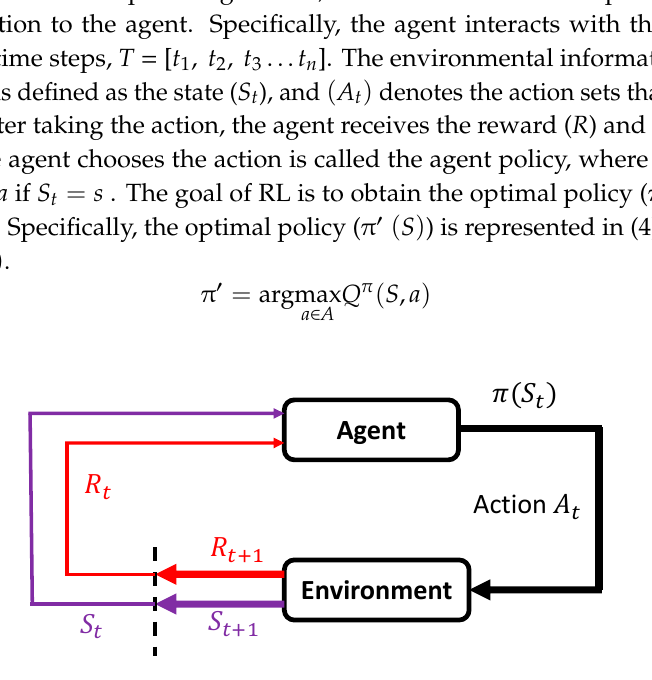
Figure 6. Structure of reinforcement learning.